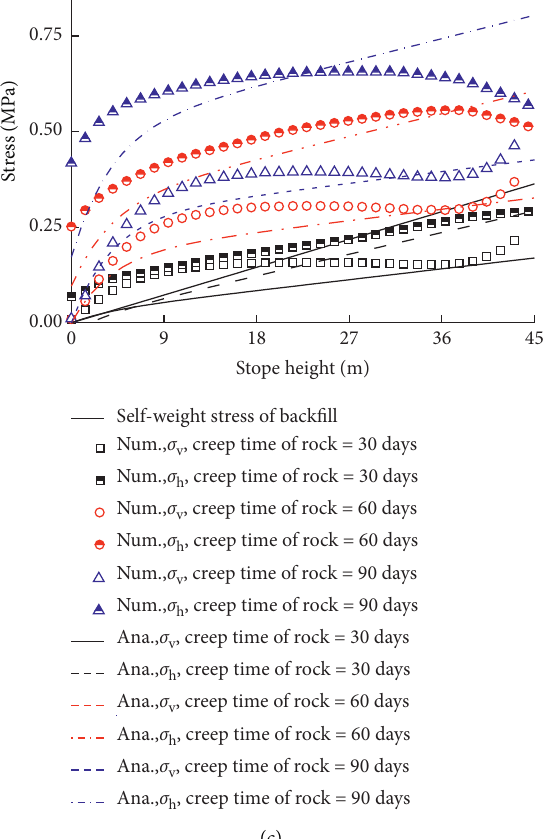
Figure 13: Theoretical and numerical results of time-dependent interaction between backfill and surrounding rock mass: (a) stope without delay filling; (b) delayed filling for 1-day; (c) delayed filling for 14-day. Table 2: Analysis of influential factors of rock creep deformation on the stress distribution of backfill. Factors